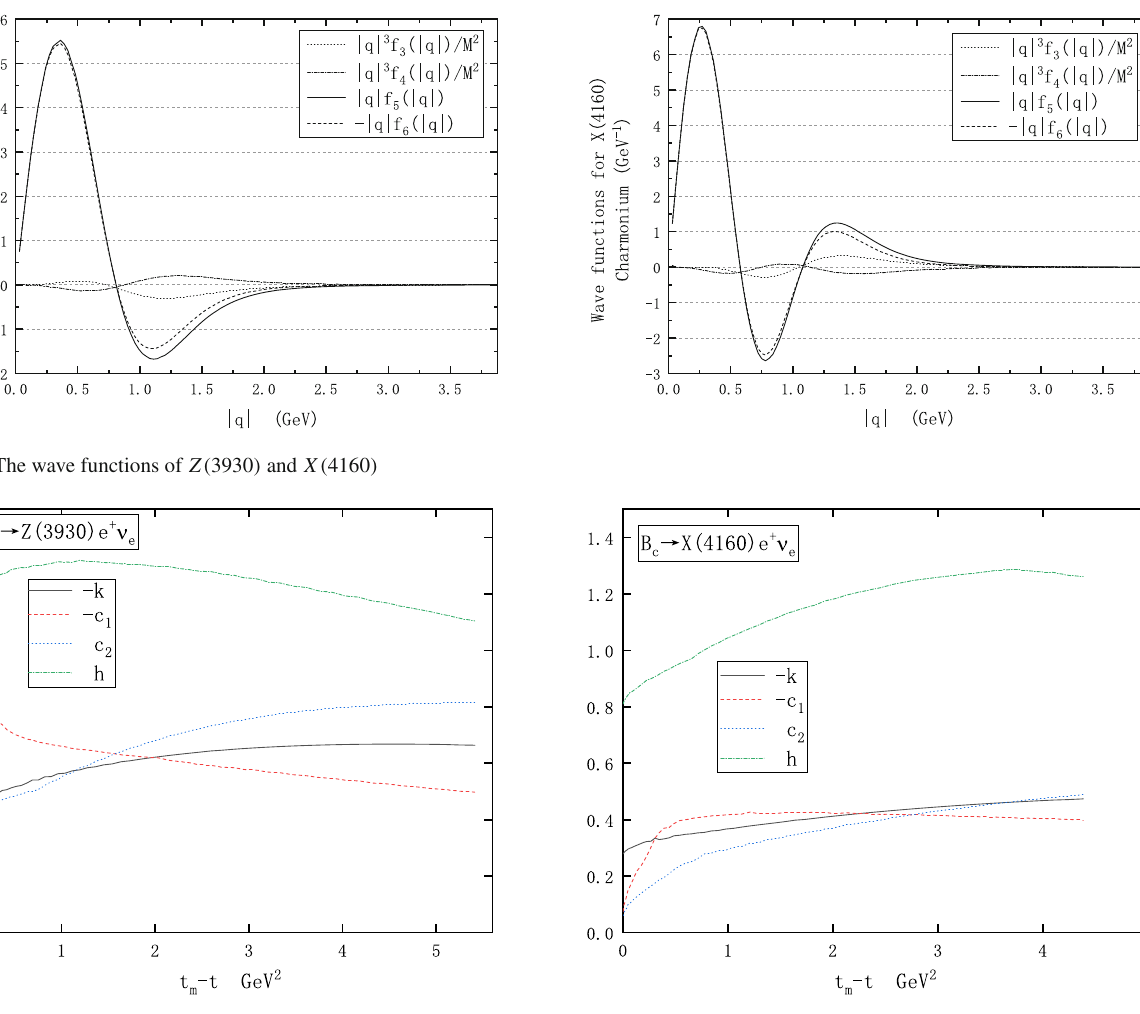
Fig. 4 The form factor of semileptonic decay B c to Z ( 3930 ) and X ( 4160